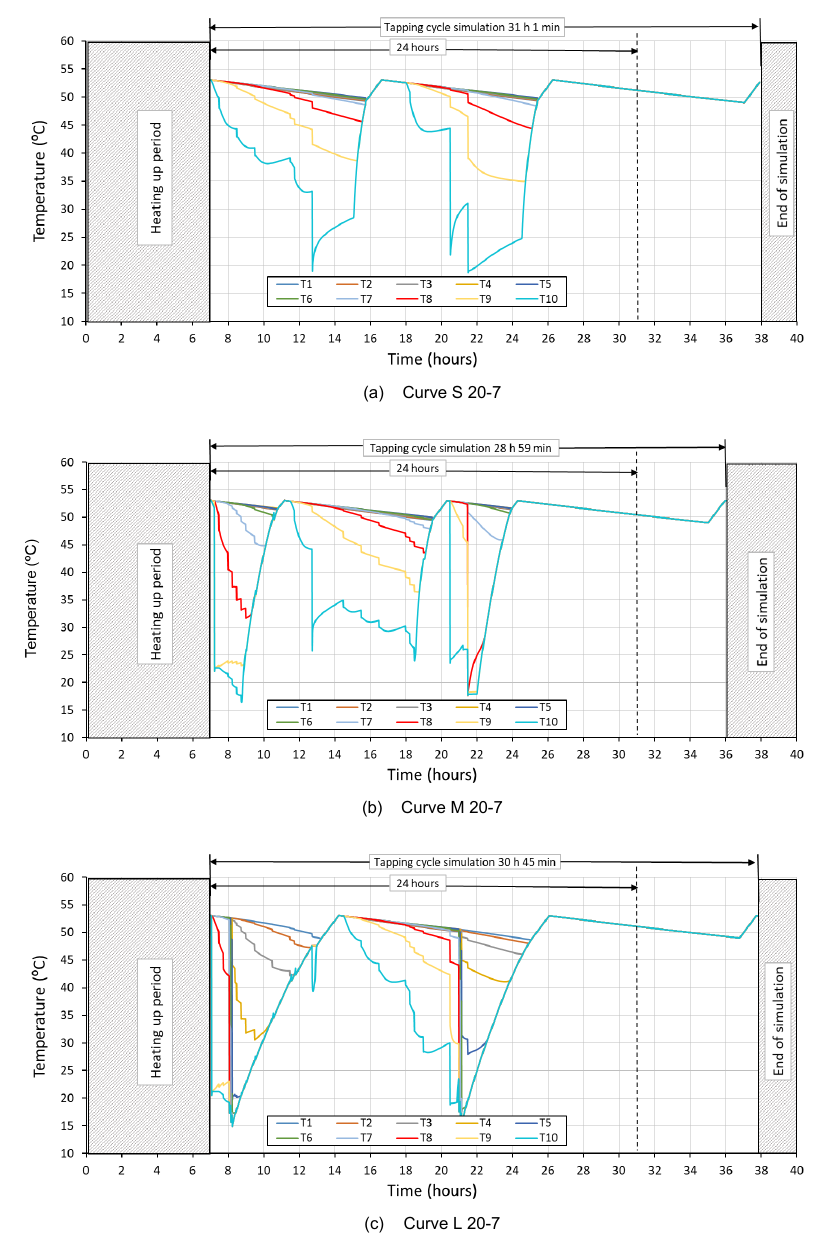
Figure 11. Numerical results for the water tank thermal stratification during Standard EN 16147